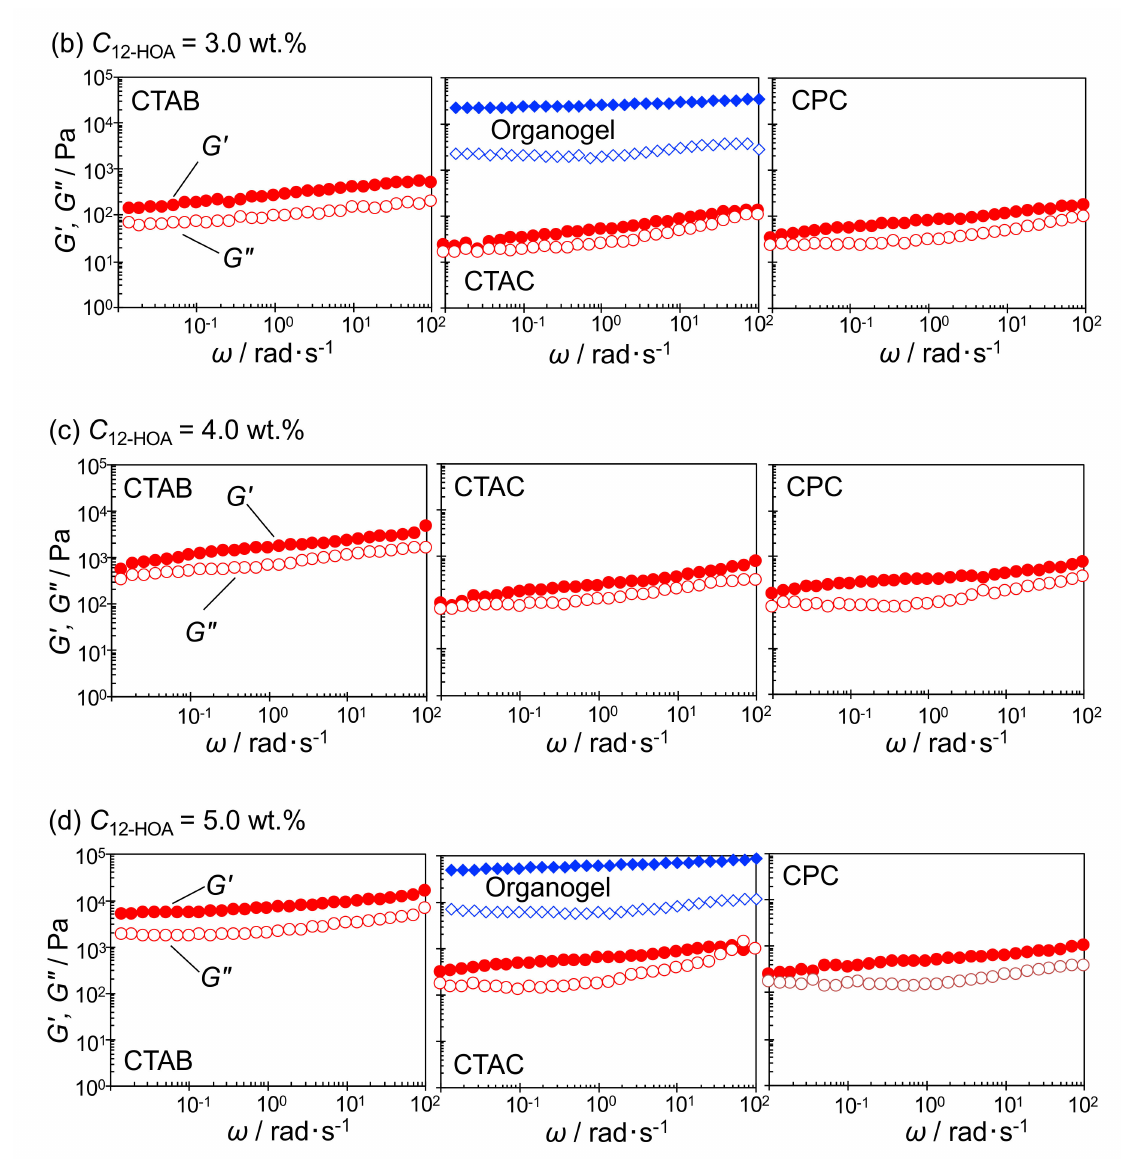
Figure 5. Storage modulus ( G (cid:48) , filled symbols) and loss modulus ( G” , open symbols) as functions of the oscillatory shear frequency ( ω ) of the hydrogels (12-hydroxyoctadecanoic acid concentration C 12-HOA = 2.0–5.0 wt.%) in the hexadecyltrimethylammonium bromide (CTAB; left), hexadecyltrimethylammonium chloride (CTAC; middle), and hexadecylpyridinium chloride (CPC; right)systemsatdi ff erent C 12-HOA (2.0–5.0wt.%)andoftheorganogels(n-decane / 12-HOA, C 12-HOA = 3.0 and 5.0 wt.%) at 25 ◦ C. ( a ) C 12-HOA = 2.0 wt.%, ( b ) C 12-HOA = 3.0 wt.%, ( c ) C 12-HOA = 4.0 wt.% and ( d ) C 12-HOA = 5.0